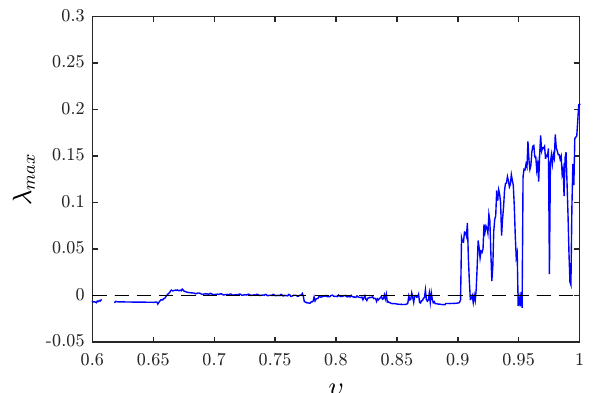
Figure 7. The largest Lyapunov exponent as a function of the fractional order υ for the same parameters and initial conditions in Figure